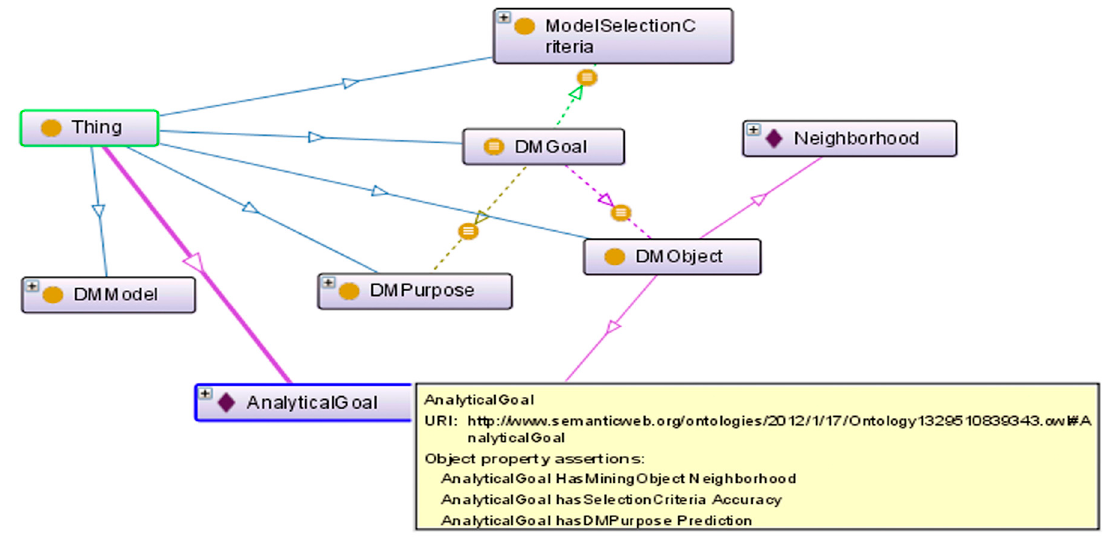
Figure 3. Onto graph Representation of DM 3 Ontology Inference.